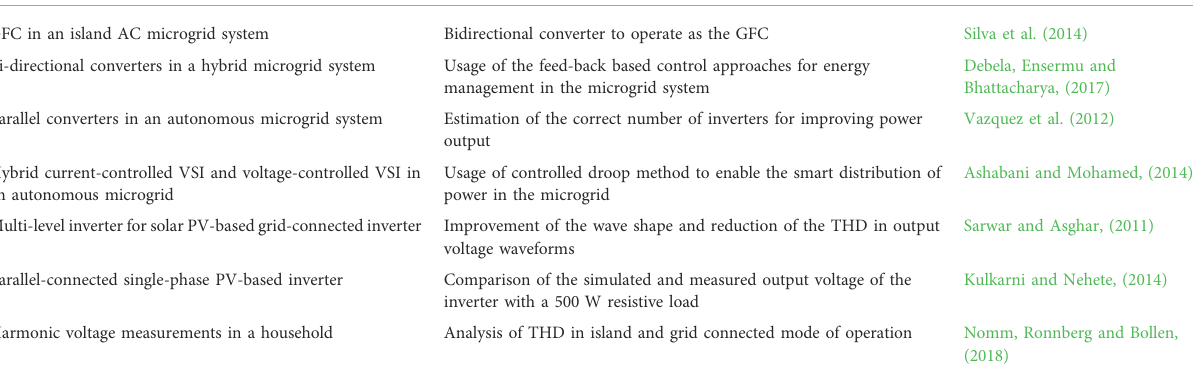
TABLE 5 Overview of inverter